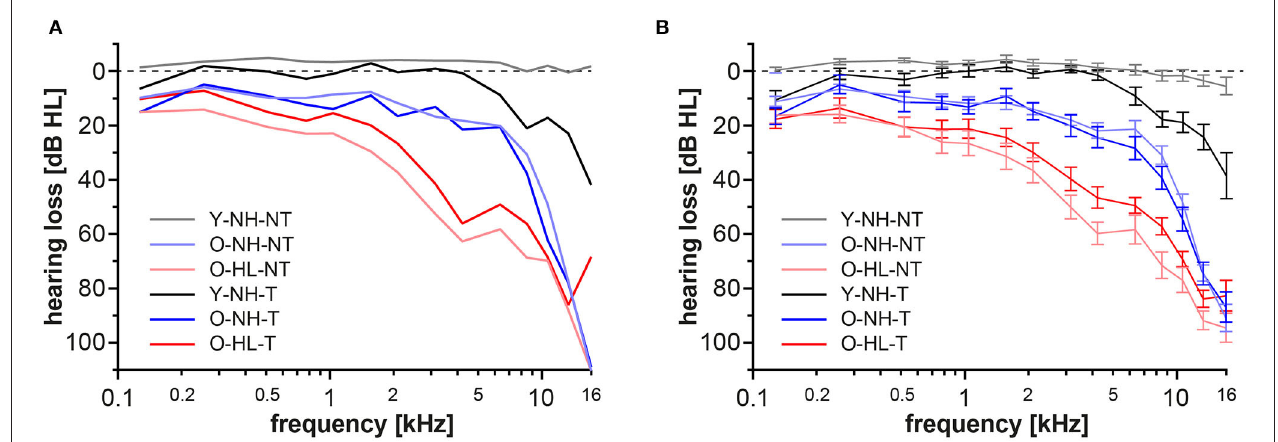
FIGURE 2 | Auditory thresholds for each group in extended frequency range up to 16kHz. Data from both ears were merged together. Values are presented as median (A) average ± standard error of the mean (SEM) (B)